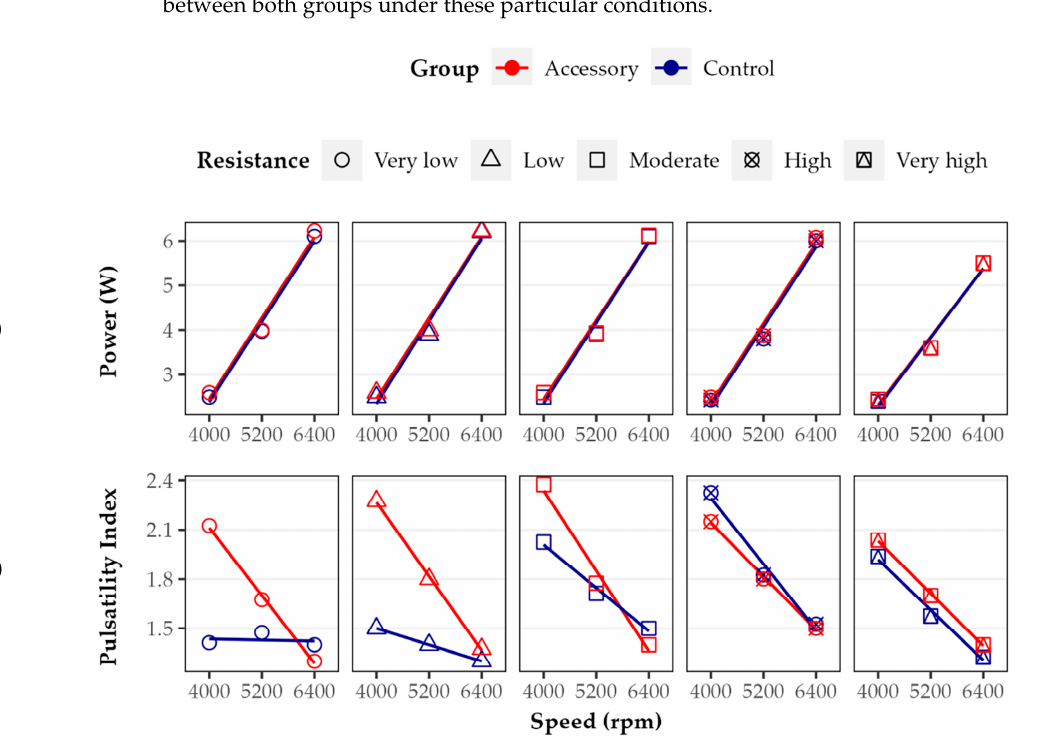
Figure 5. ( a ) Pump power and ( b ) pulsatility index of Accessory and Control groups at fi ve di ff erent resistance levels (points) with linear regression curves (lines). While power increased directly proportional to pump speed, pulsatility index decreased. Power and overall pulsatility index were higher in the Accessory group than in Control.